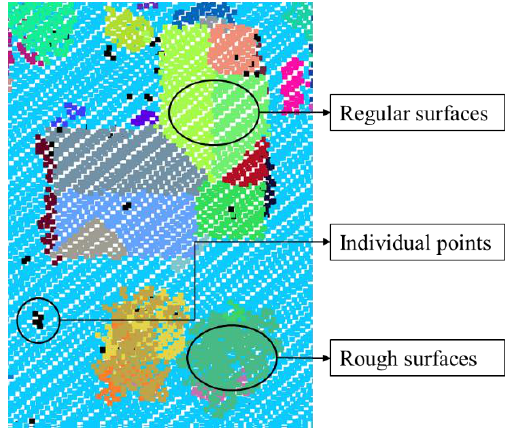
Figure 3. The three types of primitives.